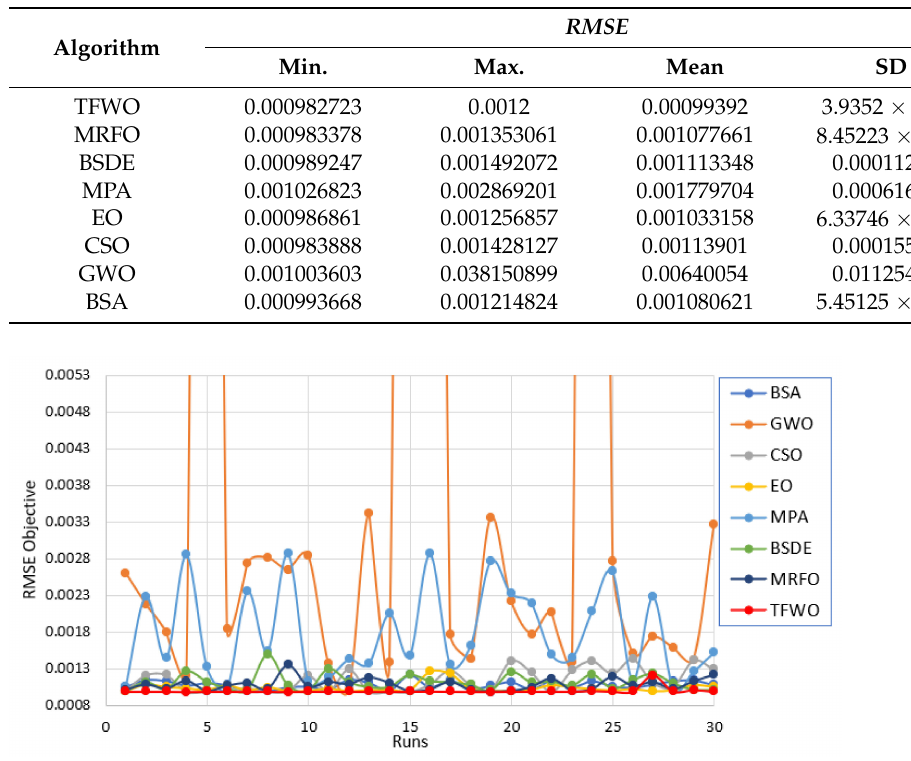
Figure 12. The RMS values of the 30 runs for R.T.C. France DDM.